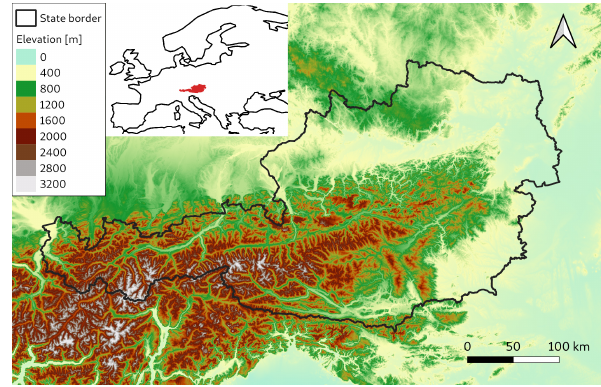
Figure 1. Area of interest with Austrian state borders. © European Union, Copernicus Land Monitoring Service 2020, European Envi- ronment Agency